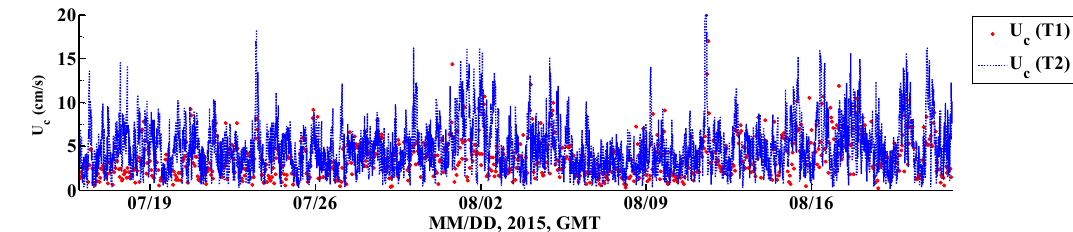
Figure 6. Current speeds in a water depth of 9.40 m below sea surface at T2 (from upward-looking ADCP) and T1 (from ADVOcean).